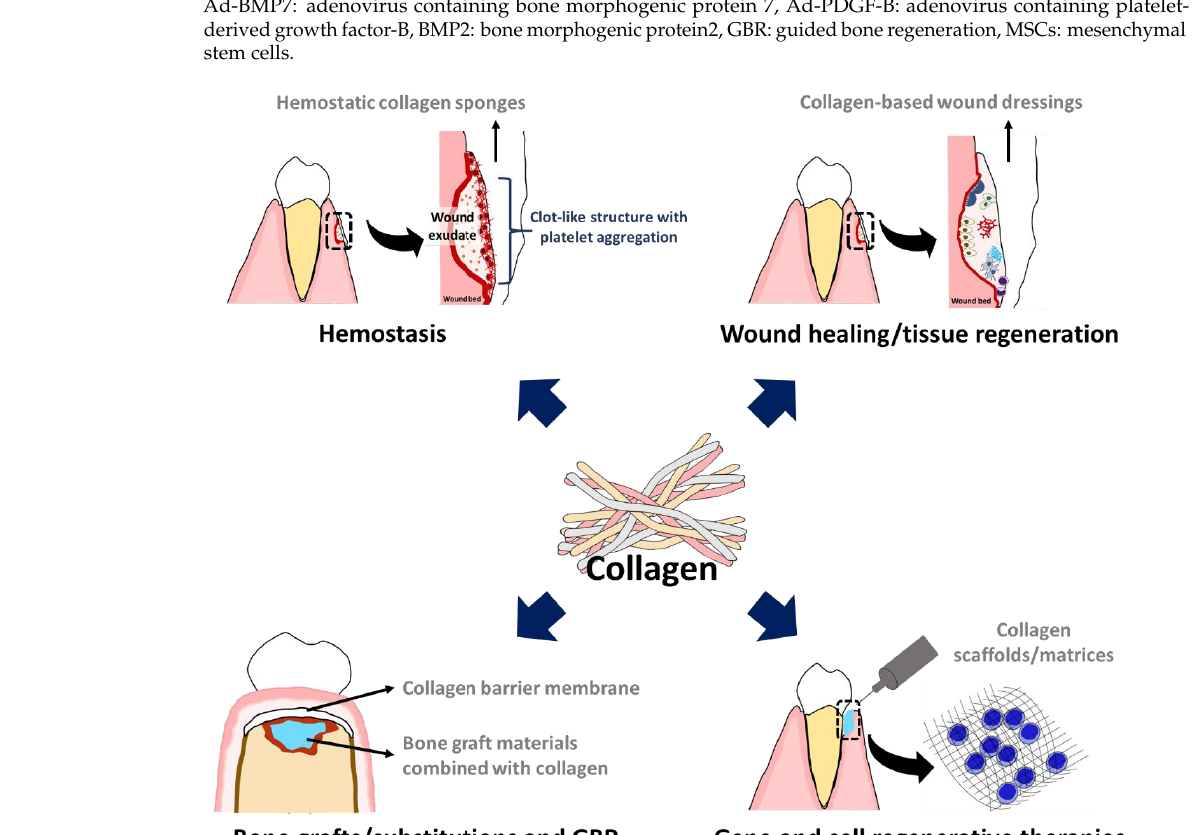
Collagen, particularly in type I collagen, is used for oral wound protection with pre- vented bleeding from the wound, and accelerated endogenous wound healing process [30,31] . Several types and forms of collagen - based products are available, including sponge - like structure, plug - like structure, microfibrillar forms, matrices, scaffold, and drug delivery carrier [30,32,33] . Clinical - based evidence suggests a positive outcome of collagen products . Application of collagen plugs in the third molar extraction resulted in relatively reduced complication rates in comparison to general conditions of previous studies [26,28] . Collagen plugs ( CollaPlug ® ) are used to fill extraction wounds, enhance clot formation, accelerate formation of granulation tissue, and reduce postoperative swelling and pain [26] . Ateloplug, a 100 % absorbable collagen sponge, appeared to provide hemo- stasis when applied to the extraction socket . In addition, collagen - containing dressing showed faster wound healing by deposition of fiber in granulation tissue, accelerated re - epithelization, and promoted remodeling of ECM [28,27] . After being placed, collagen rapidly absorbs blood by generating artificial clot - like structure to stop bleeding, thereby reducing swelling and pain postoperatively . Collagen affects coagulation processes . Once it contacts the blood, collagen provides a three - dimen- sional matrix via binding with a large number of platelets, causing platelet aggregation . Aggregated platelet is granulated to secrete thromboxane A2 that helps and strengthens the formation of blood clot [34,35] . Later, the collagen degrades and collagen fragments